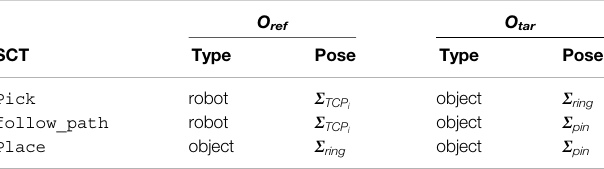
TABLE 2 | Mapping of O ref and O tar for the individual SCTs implemented for MIRS